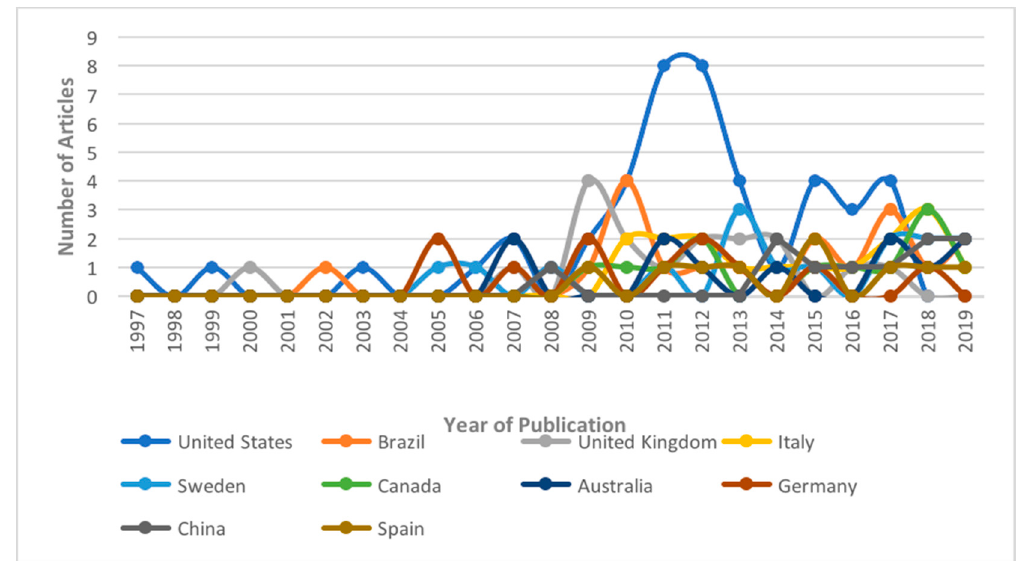
Figure 6. Temporal distribution of top 10 most productive countries of renewable energies and sustainability articles.